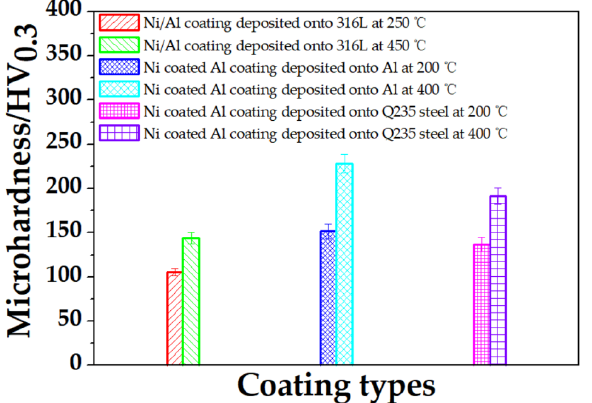
Figure 14. Microhardness of the coatings deposited onto different substrates in different accelerating gas temperatures.